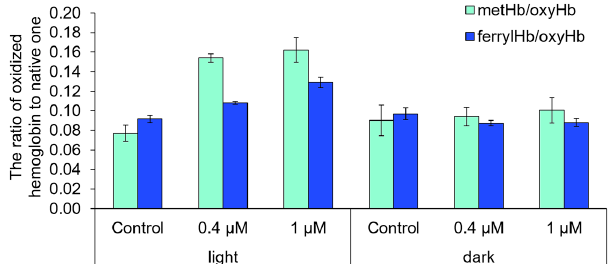
Figure 9. The relation of oxidized forms of hemoglobin (metHb and ferrylHb) to the native one (oxyHb) in erythrocytes’ hemolysates after 5 h of incubation with the tested Compound 21 (0.4 and 1 μ M).